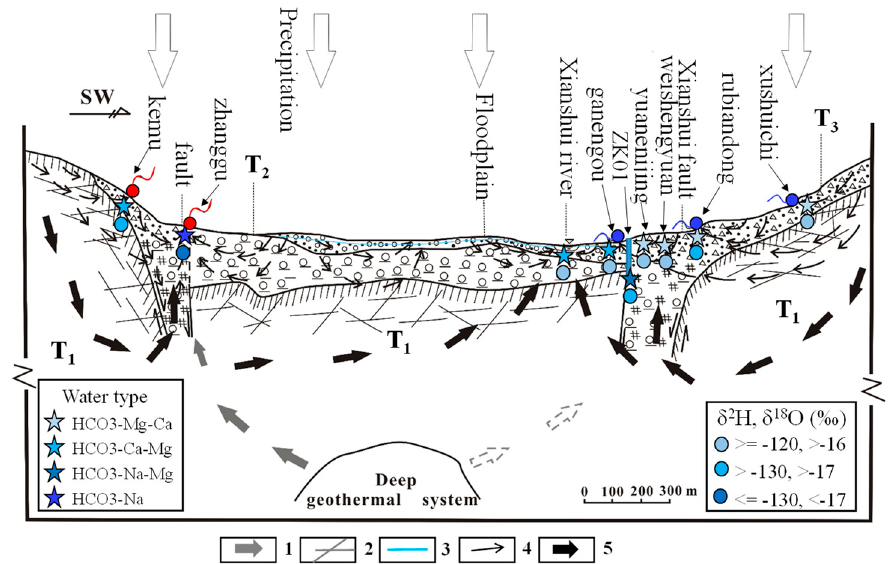
Figure 11. Fractured groundwater systems in the study area (note: 1. regional deep groundwater flow system (the bold grey arrows); 2. fractured and weathered zone; 3. water table; 4. local shallow groundwater system (the small thin black arrows); 5. intermediate groundwater flow system (the bold black arrows). Other symbols are the same as those in Figure 1).